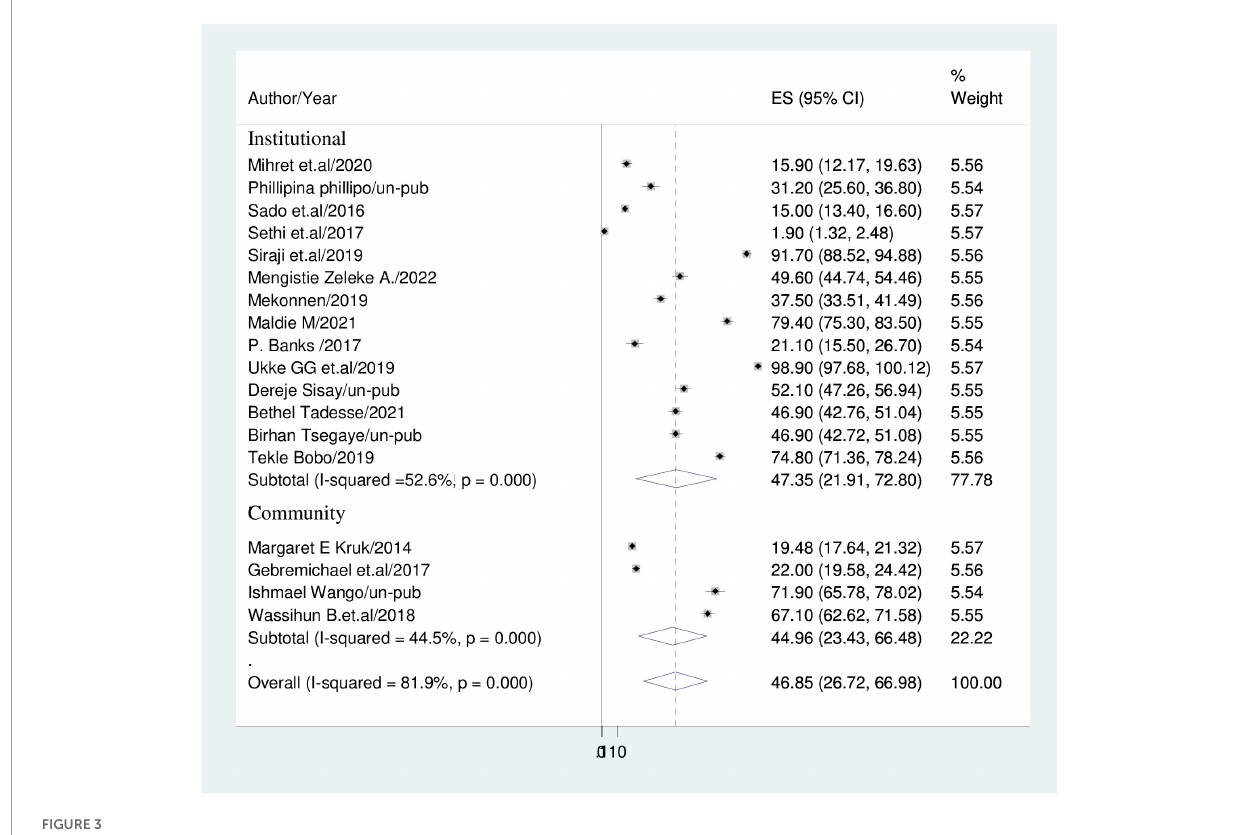
FIGURE3 Forest plot displaying sub-group analysis based on study setting.